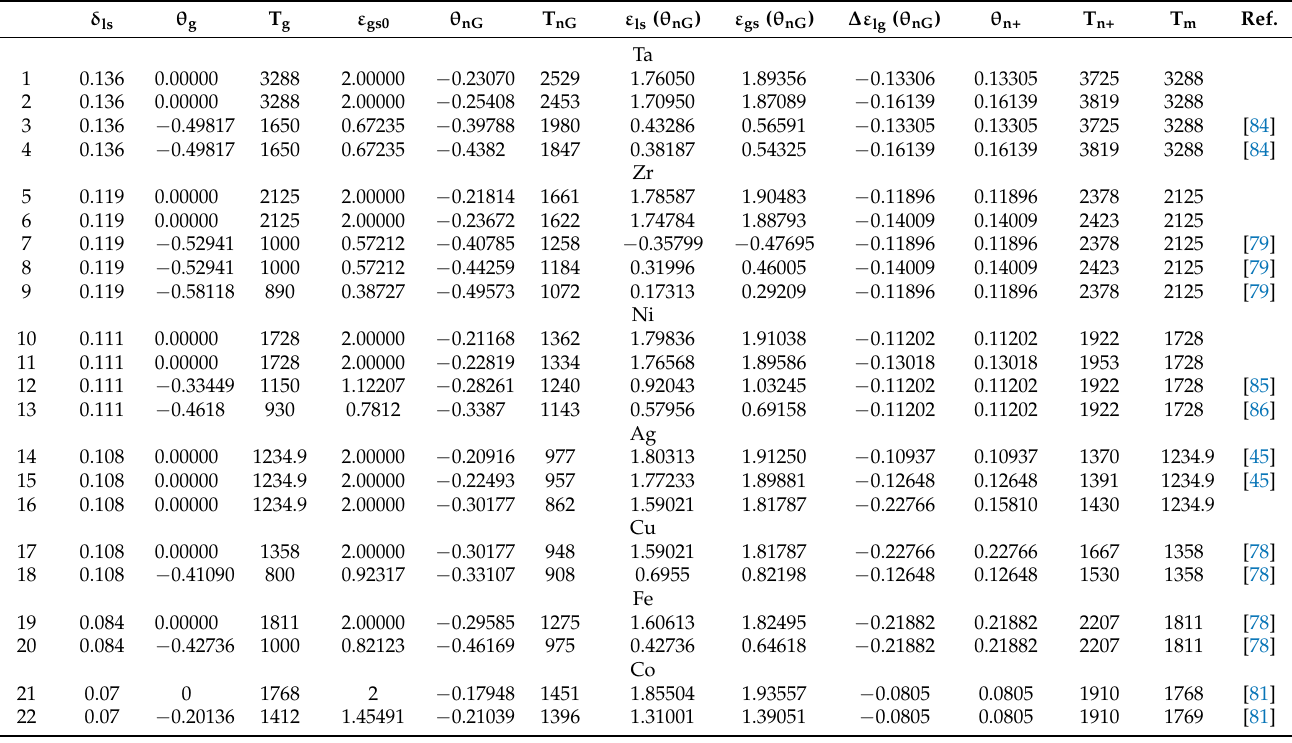
Table 4. Application of NCHN model to Ta, Zr, Ni, Ag, Cu, Fe and Co. θ g and T g for various heating and cooling rates R in K/s; ε gs0 deduced from Equation (8) with ∆ ε = 0; θ nG the reduced nucleation temperature of glacial phase leading to singular values ∆ ε lg ( θ nG ) = ε ls ( θ nG ) − ε gs ( θ nG ) = − θ n+ ; ε ls ( θ nG ) and ε gs ( θ nG ) deduced from Equations (4) and